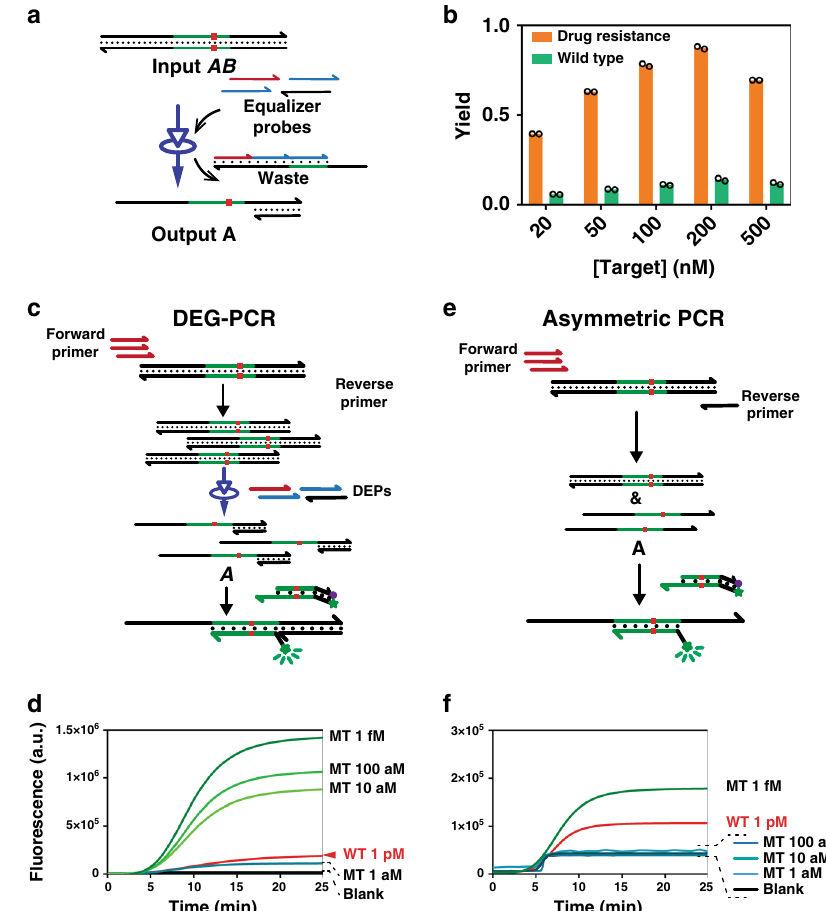
Fig. 6 Integration of DNA Equalizer Gate (DEG) with polymerase chain reaction (PCR). a Schematic illustration of analyzing dsDNA using a 4-DEP design. b Experimental validation of the 4-DEP design for the detection of an 87 bp dsDNA as a mimic of PCR amplicon. The concentration of outer DEPs was fi xed at 500 nM and that of inner DEPs was set to be 200 nM. Individual replicates ( n = 2) are shown as circles. c Schematic illustration of DEG-PCR using a 4-DEP design. The outer two DEPs (red and black) are designed to be identical with PCR primers. d Real-time monitoring of DEG-PCR using a toehold-exchange reporter. A wide detection window was achieved, where as low as 10 aM of correct template could be clearly discriminated from 1 pM spurious target containing a single nucleotide mutation. e Schematic illustration of the asymmetric PCR followed by the detection using a toehold-exchange reporter. f Real-time monitoring the detection of asymmetric PCR amplicon revealing a much narrower detection window than DEG-PCR, where correct discrimination could be made only above 1 fM. Source data are available in the Source Data fi